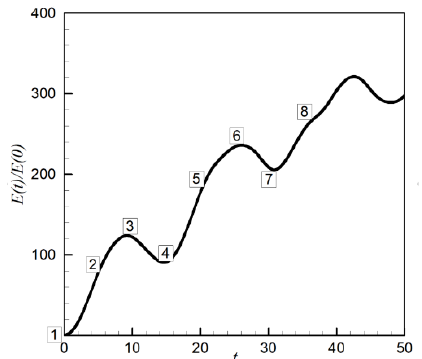
Figure 7. Growth function of the 3D optimal temperature perturbation superposed with base flow profile for Ri = 2, Re = 1000, α = 0.5, β = 1. The numbers represent different stages of increase and decrease in growth function. The optimal disturbances corresponding to some of these stages are shown in Figure 8.